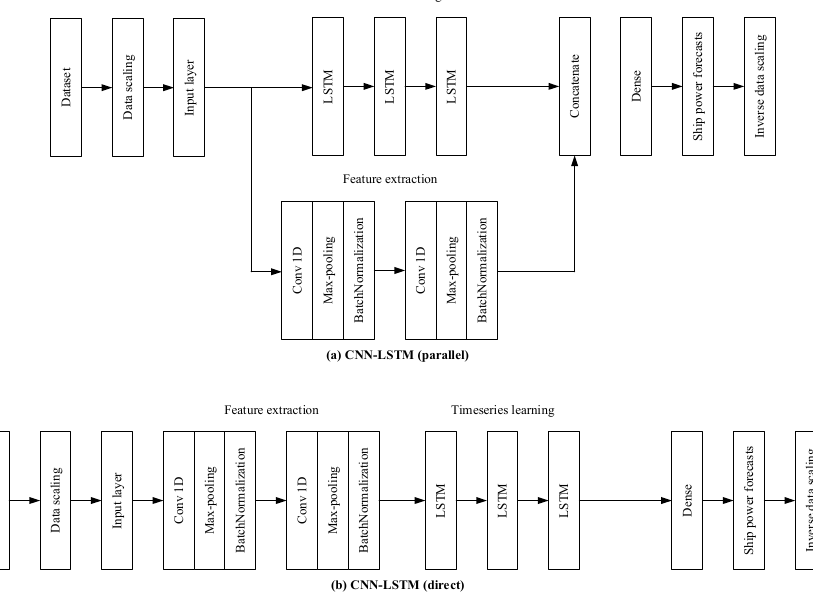
Figure 7. Structures of CNN-LSTM models for comparison: ( a ) Parallel; ( b )